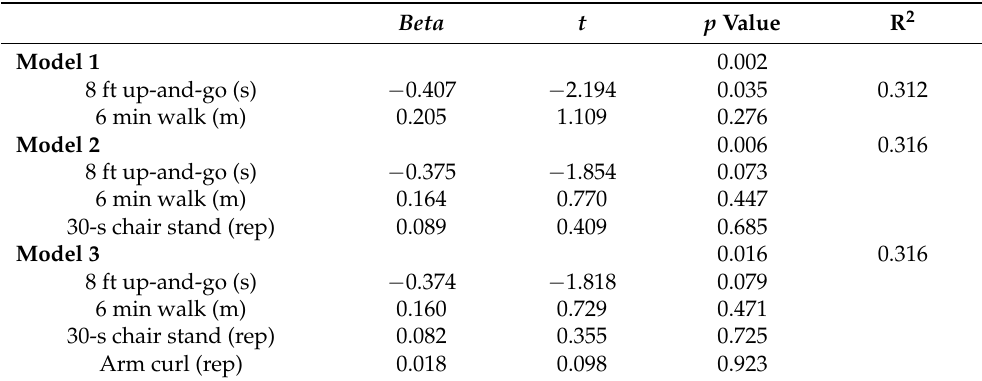
Table 6. Multiple linear regression (backward stepwise). Phase angle as a predictor for physical function. Only